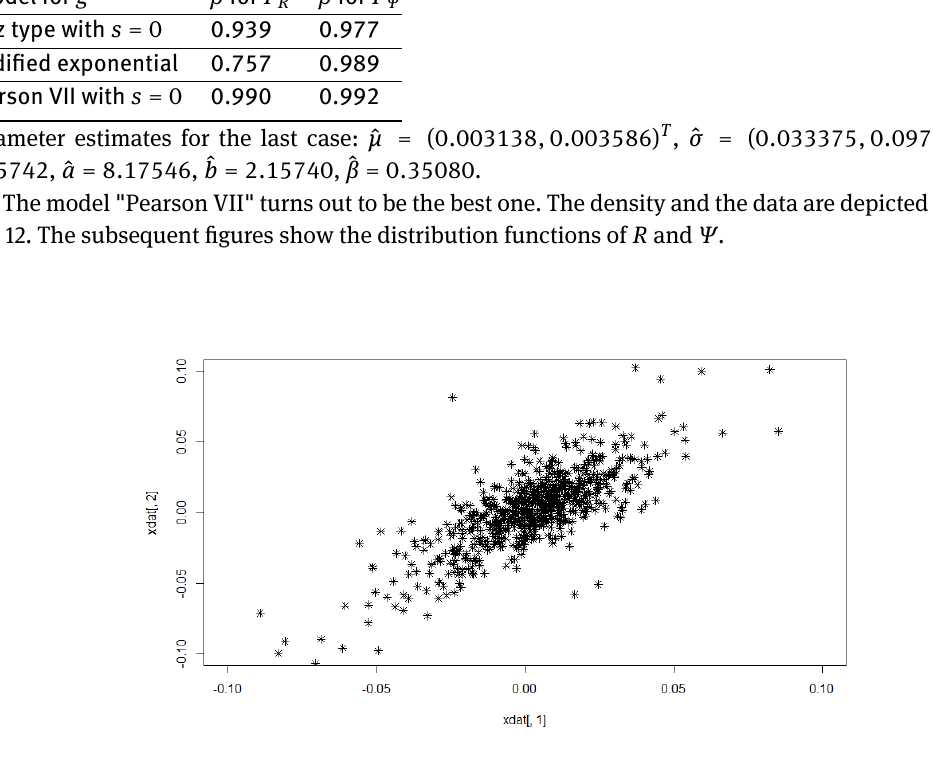
Figure 11: scatter plot of the data